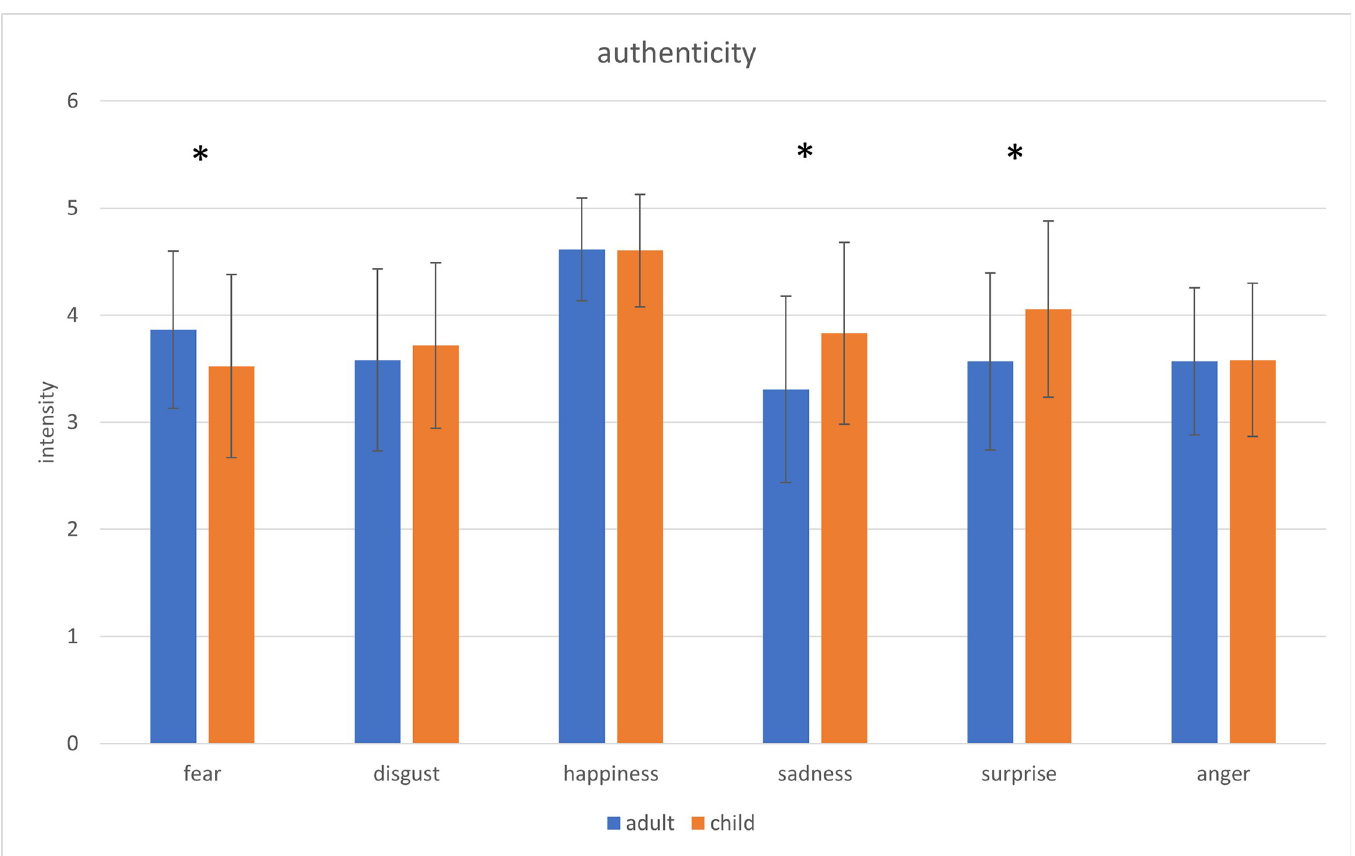
Fig 5. Comparison of the ratings of intensity regarding authenticity of the presented adults’ and children’s affect expressive faces. The error bars represent the standard deviation. � = p < .05.